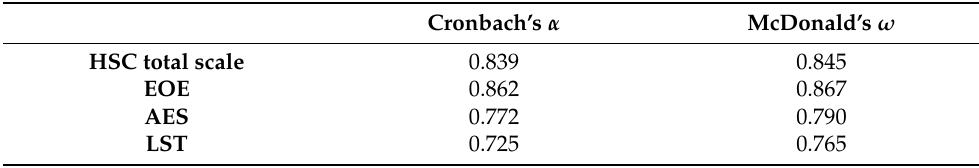
Table 4. Internal